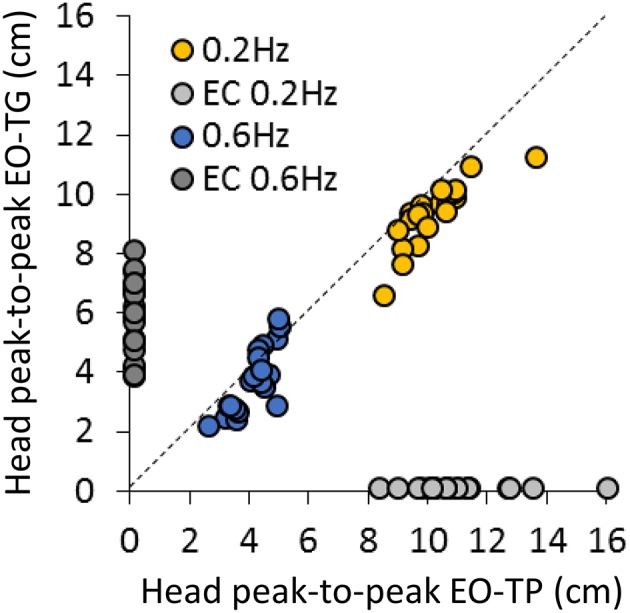
Comparison of head P-P displacements between the EO-TP and the EO-TG condition at 0.2 Hz (yellow dots) and at 0.6 Hz (blue dots) translation frequency. Each point corresponds to a subject. The dotted line is the identity line. Light gray and dark gray dots correspond to the head P-P under EC condition at 0.2 Hz (near the abscissa) and 0.6 Hz frequency (near the ordinate), respectively. At 0.2 Hz, P-P values were always smaller at EO-TP than at EO-TG. A similar but less consistent behavior was observed at 0.6 Hz.